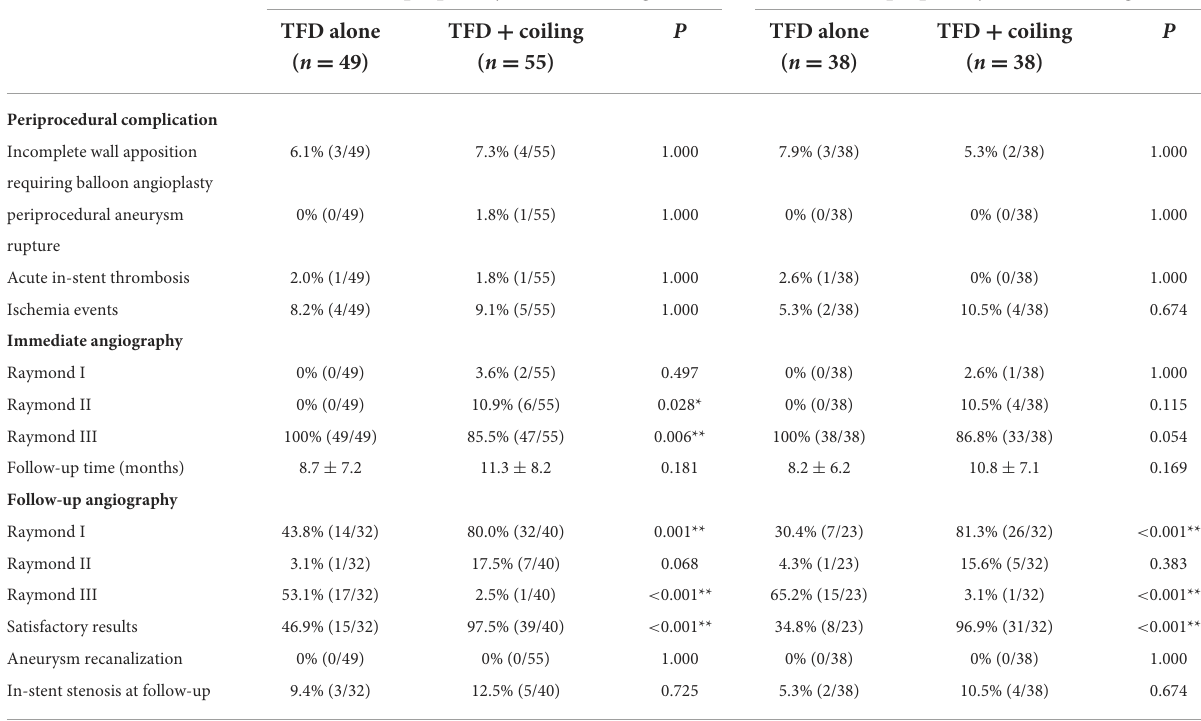
TABLE 2 Periprocedural complications and angiography